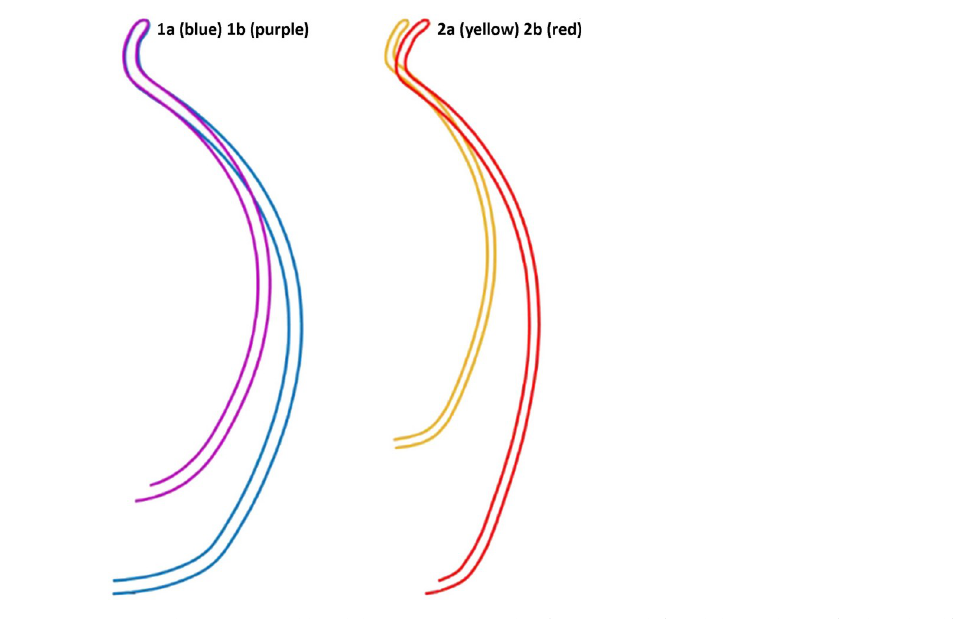
Fig 4. The average profiles of the two main branches (Types 1 and 2) and their subtypes (1a/b and 2a/b). https://doi.org/10.1371/journal.pone.0254766.g004 (Tables 2 and 3). In general, their values are significantly different (Mann-Whitney test, p < 0.001); in particular, the rim-curve lengths show a difference between subtypes 1a and 1b, and between 1b and subtypes 2a and 2b. The rim’s radius and the neck-curve lengths show bet- ter significance, whereas Type 1 differs from Type 2. However, Subtypes 2a and 2b show signif- icant differences in their values. The rim- and neck-curve lengths indicate a minute difference in each type’s profile. Type 1 has relatively shorter rim- and neck-curves, whereas those of Type 2 are longer. The landscape unit scale. A cluster tree with landscape units was produced according to the weights mentioned above (Fig 5). The automatic morphological classification divided the geographical units between the main branches and their subtypes. Type 1, marked in cold colors, comprises 76% of the North region, while Type 2, marked in warm colors, makes up 90% of the South region. Table 1. Significance test results for the rim’s radius among the